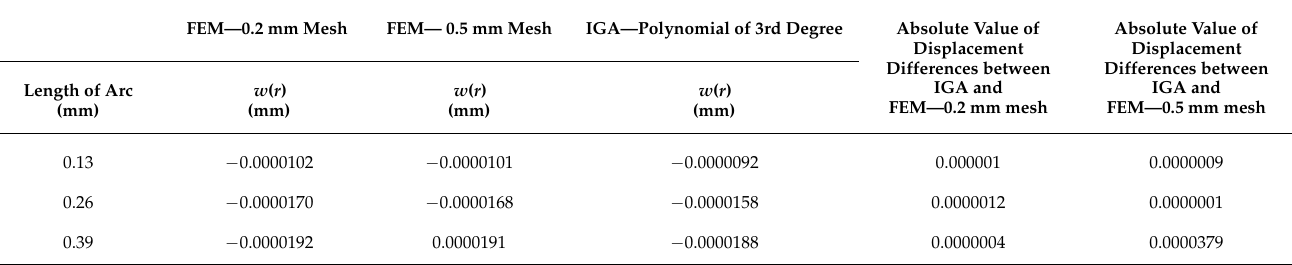
Table 2. Computed displacements of the points for the different solution methods.